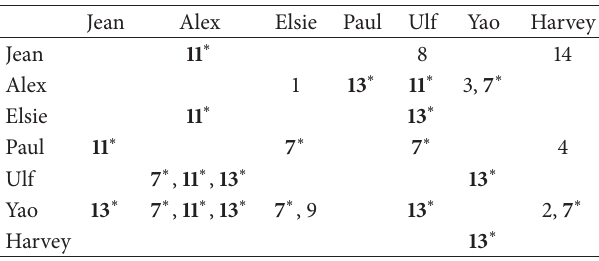
Table 2: Topics among known conspirators.